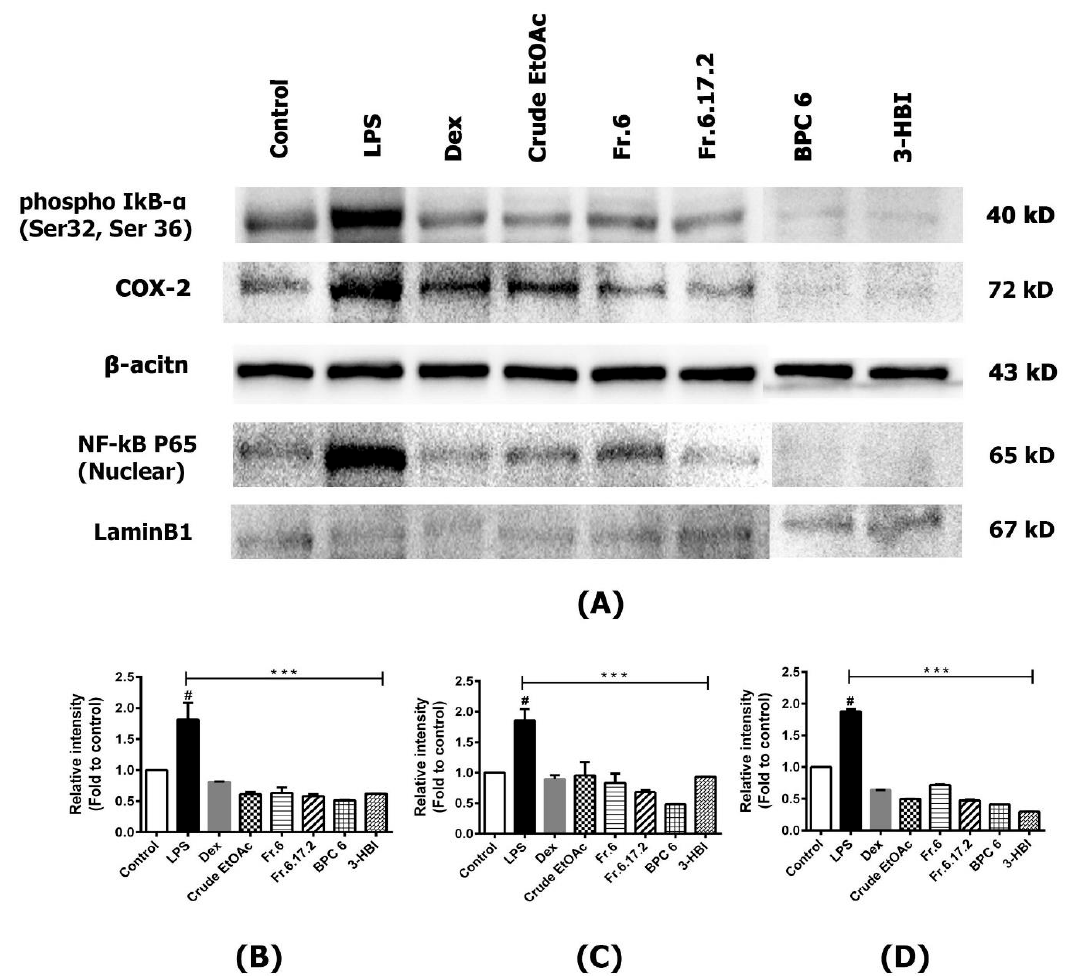
Figure 6. E ff ect of MO extract on the protein expressions in MDM. ( A ) Total protein and nuclear protein levels by western blotting using specific antibodies, including NF- κ B P65, phospho-I κ B α , and cox-2; β -actin was used as a loading control. ( B ) Relative protein levels of phospho-I κ B α , ( C ) COX-2, and ( D ) NF- κ B P65 (Nuclear), were quantified by scanning densitometry and normalized to control. Data are presented as means ± SEM. # p < 0.001 compared to control, *** p < 0.001, compared to LPS. Control: Untreated MDM; LPS: Lipopolysaccharide-stimulated MDM; Dex: Dexamethasone; Dex + MO: combination of Dexamethasone and crude EtOAc; Crude EtOAc: Crude ethyl acetate; Fr6: Fraction 6; Fr6.17.2: Fraction 6.17.2; BPC 6: base peak chromatogram 6; 3-HBI: 3-Hydroxy- β -ionone.